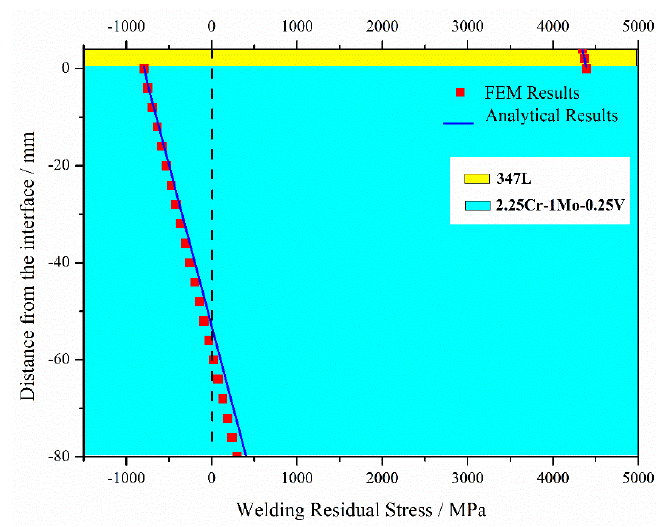
Figure 8. Welding residual stress (WRS) calculated from analytical and numerical simulations of the elastic model.